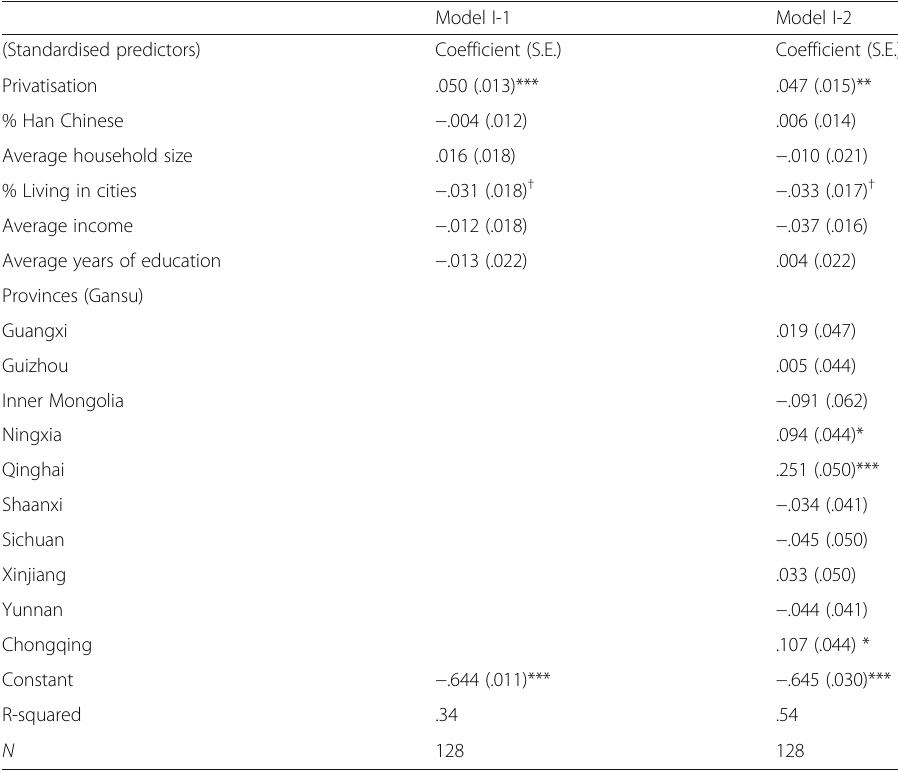
Table 2 OLS estimates for log Gini, full model Model I-1 Model I-2 (Standardised predictors) Coefficient (S.E.) Coefficient